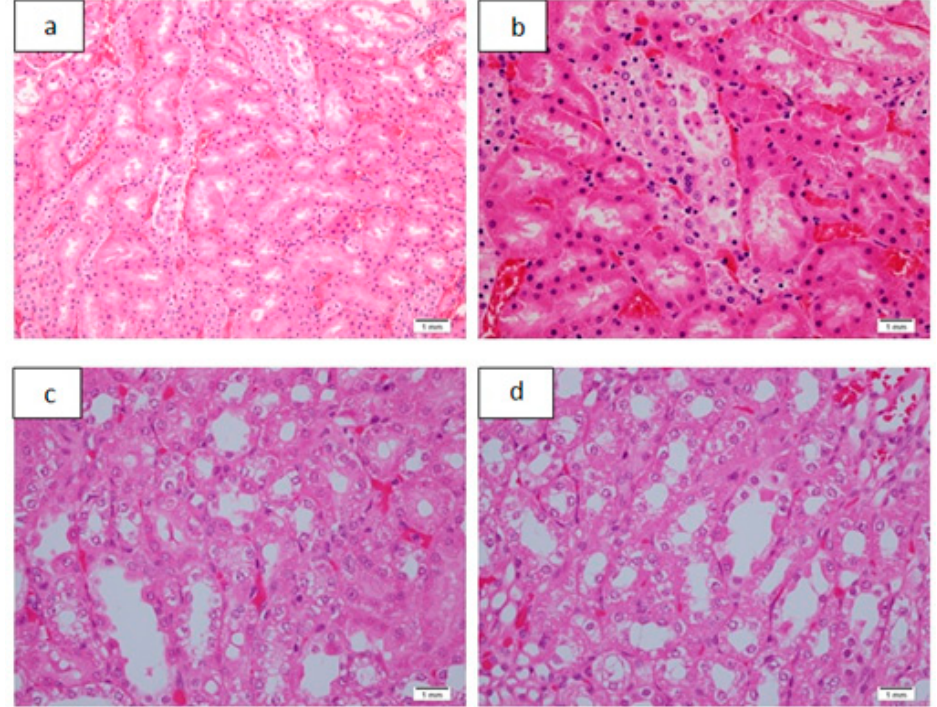
Figure 3. Renal tubular histological alterations as seen in acute toxicity study. ( a ): Renal tubular